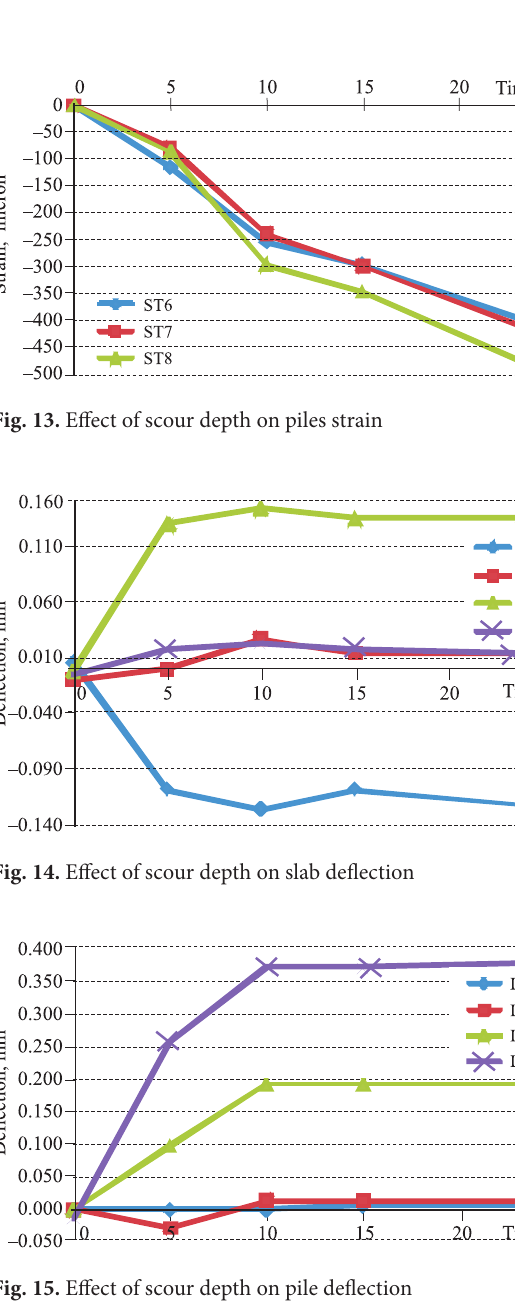
Fig. 12. Effect of scour depth on slab